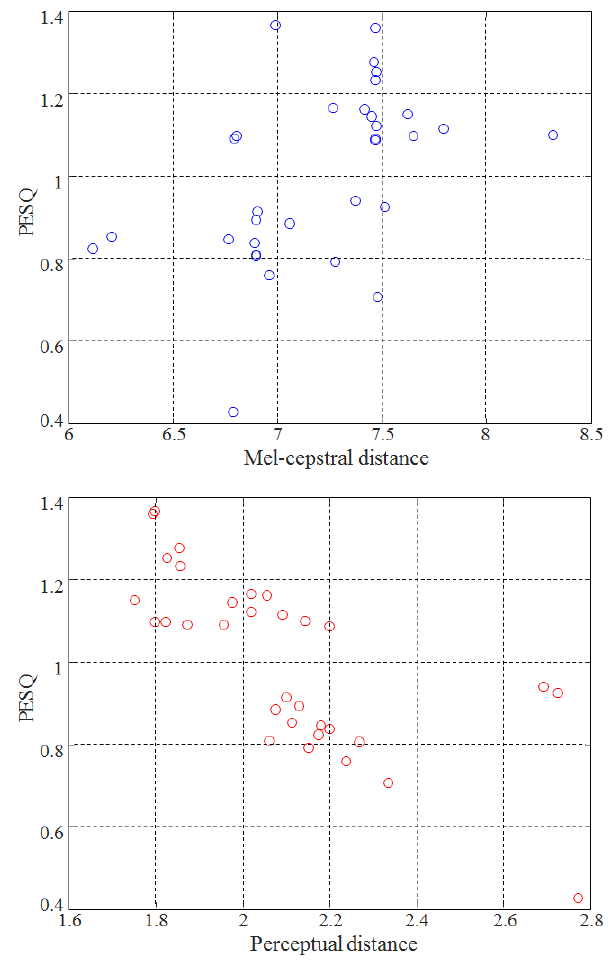
Figure 7. Scatterplot of PESQ values. Top: Mel-cepstral distance. Bottom: Perceptual